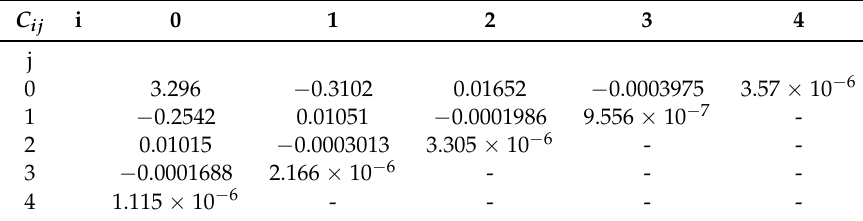
Figure 10. The optimal satellite beamwidth with different SINR thresholds. It shows that the optimal antenna beamwidth for the satellite is from 22 ◦ to 28 ◦ based on the simulation. Table 5. Surface Polynomial Coefficients for Class